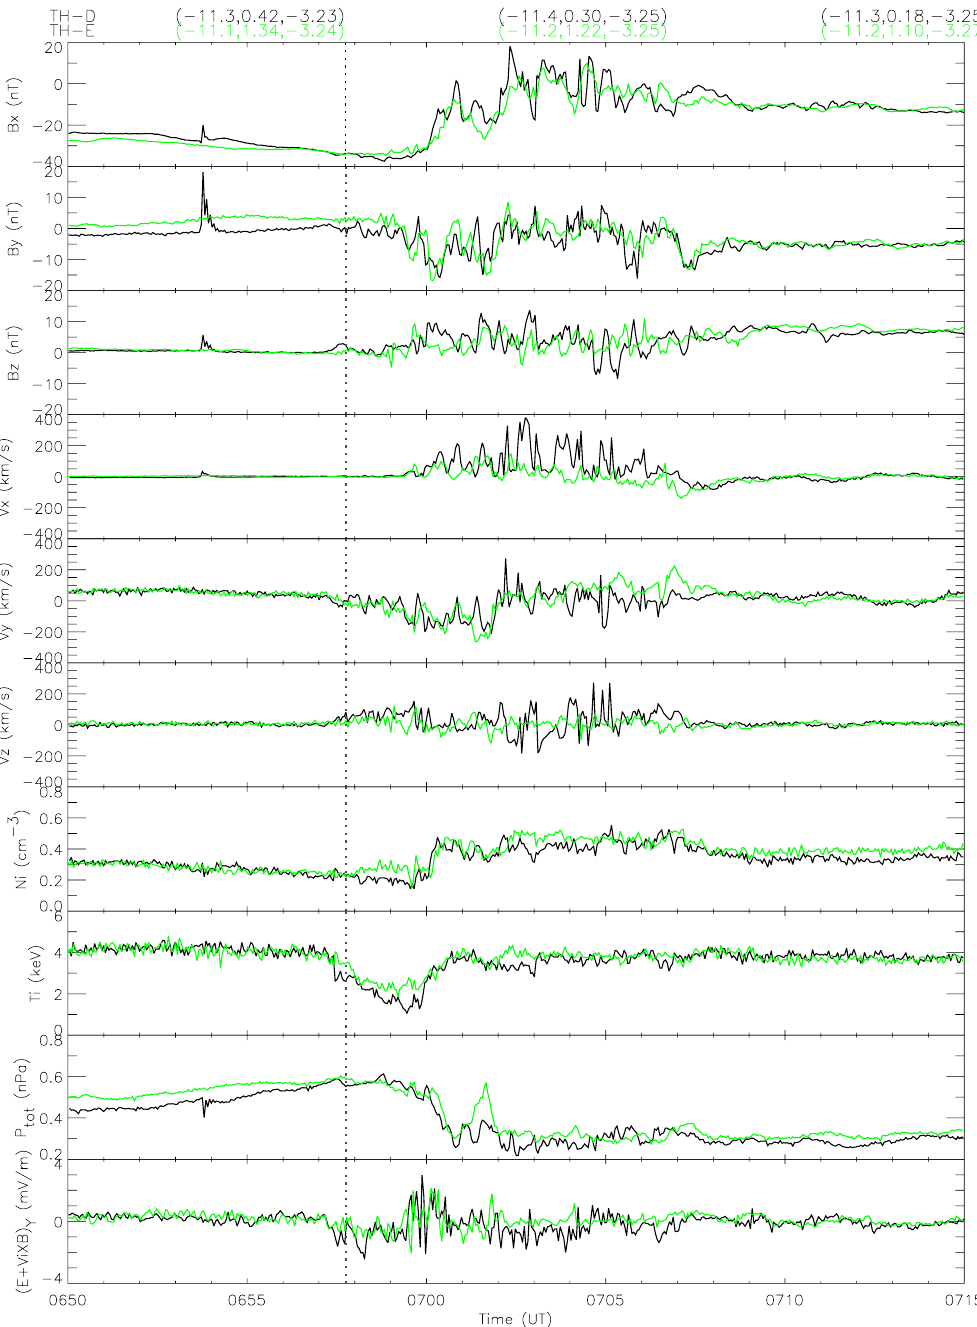
Fig. 6. THEMIS observations for 13 February 2008 event. From top to bottom are the three magnetic field components in GSM coordinate, ion flow velocities in GSM coordinate, ion number, ion temperature, total pressure and the DSL-Y component of E + u i × B from TH-D (black) and TH-E (green) FGM, ESA & EFI